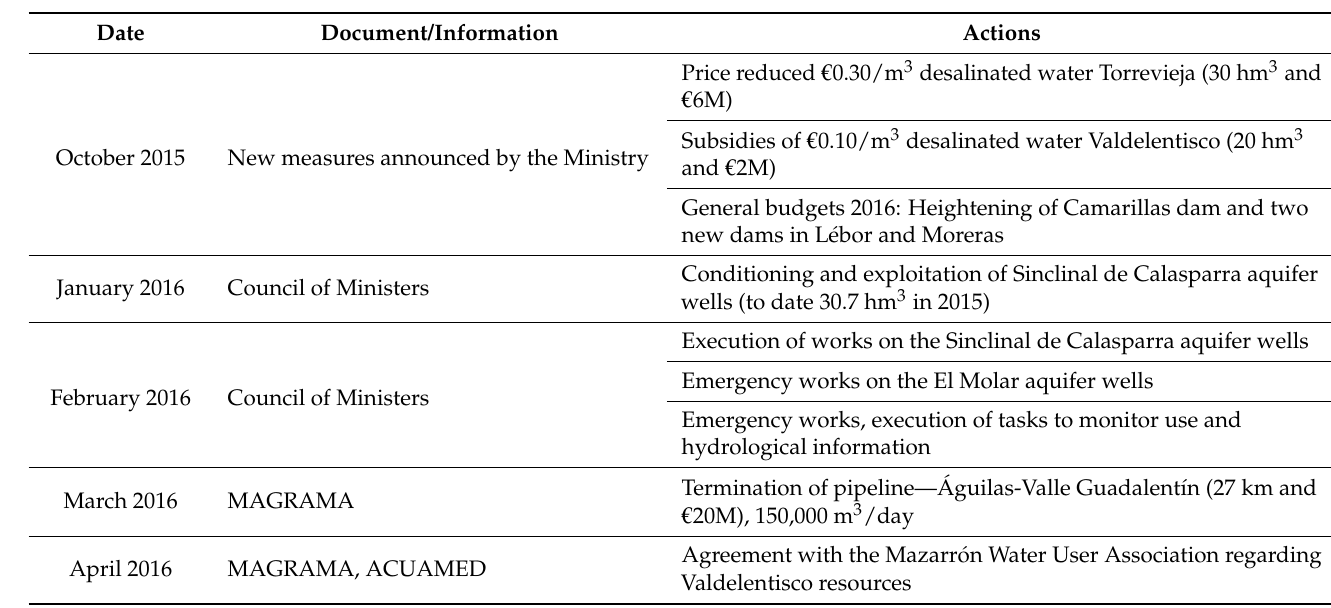
Table 14. Actions carried out in the area of the SRB during the water year 2015/16. Source: own elaboration based on